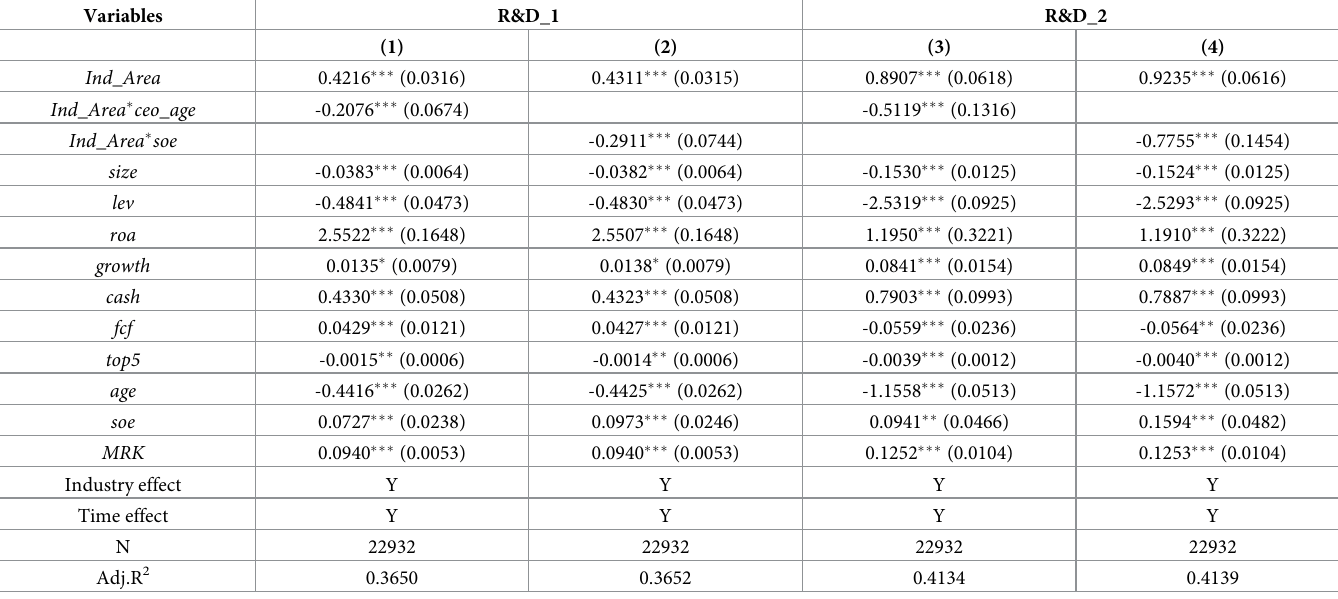
Table 7. Similarity between the comparison group and the real effects of CEO awards.